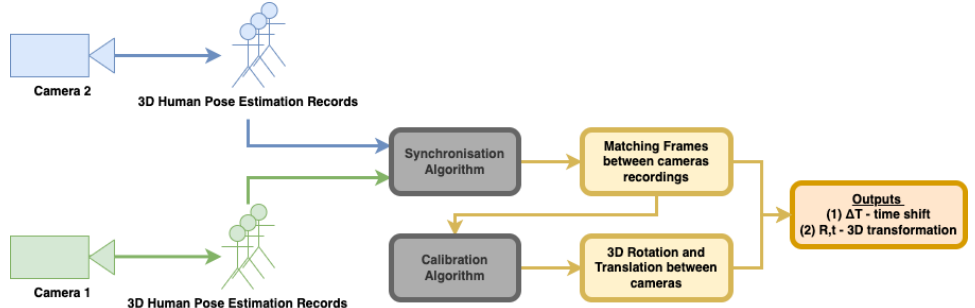
Figure 3. The workflow of the proposed spatio-temporal calibration approach.